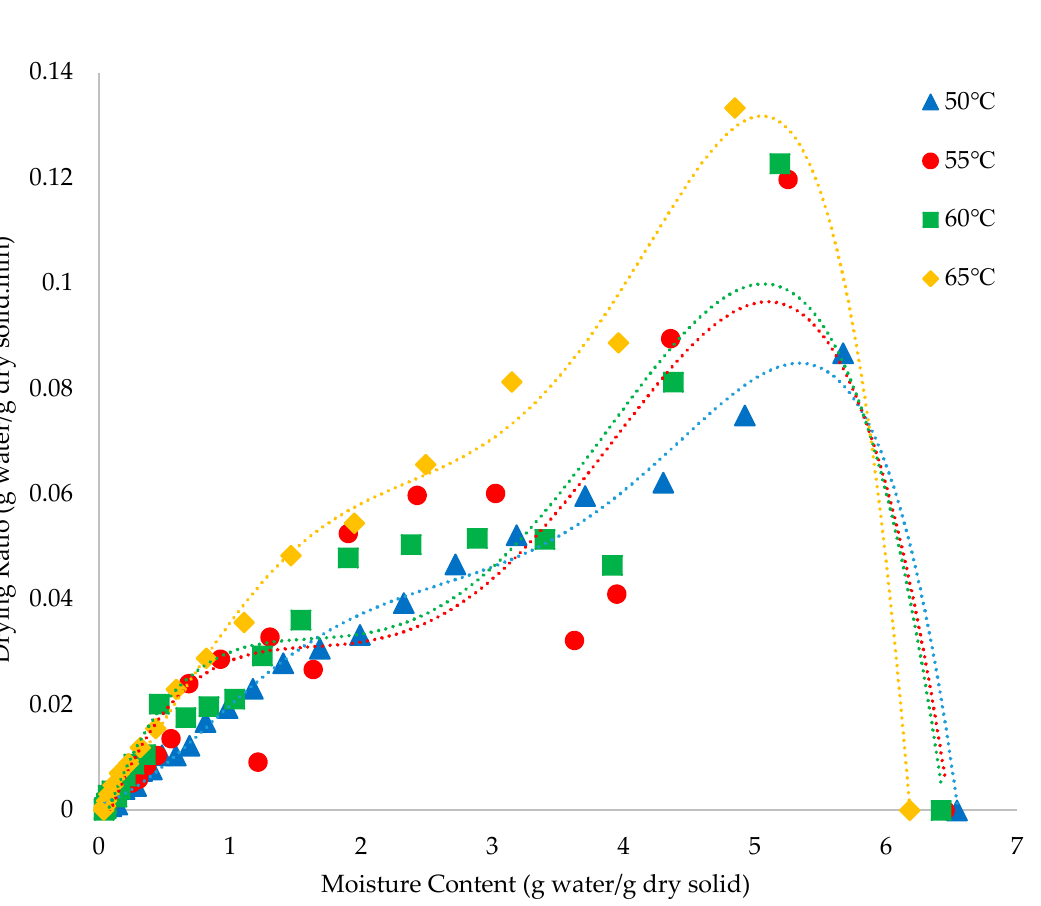
Figure 4. Drying rate curves of lemongrass slices at different temperatures.